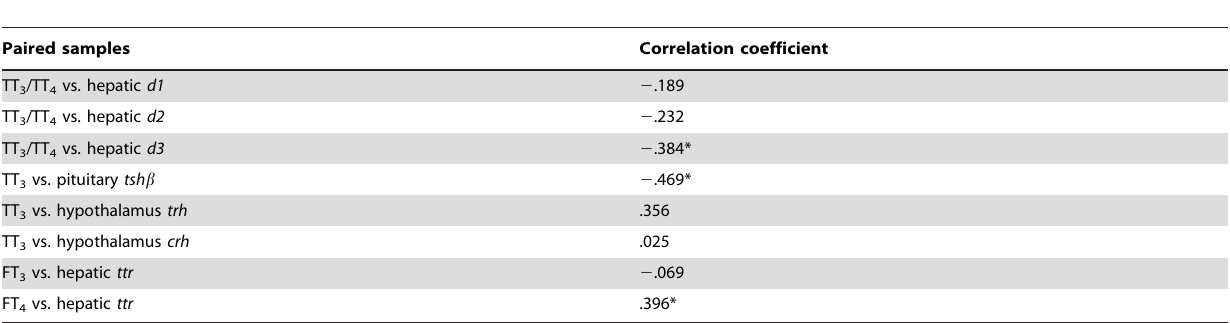
Table 2. Pearson correlation coefficients for the plasma thyroid hormone levels and the expression of certain genes related to the hypothalamus-pituitary-thyroid